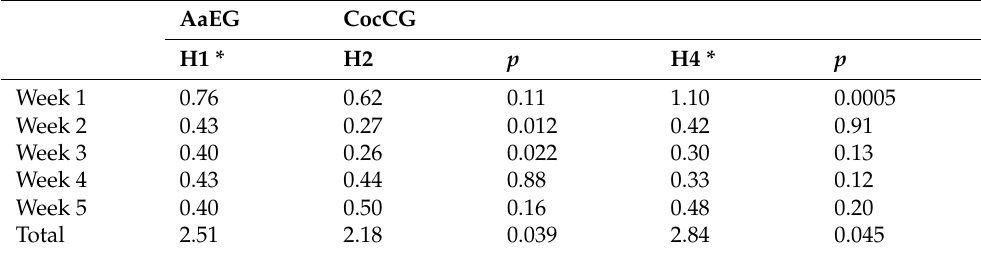
Table 2. The mortality rate in broiler chickens fed with A. annua supplemented feed in comparison with broiler chickens fed with anticoccidial supplemented feed.